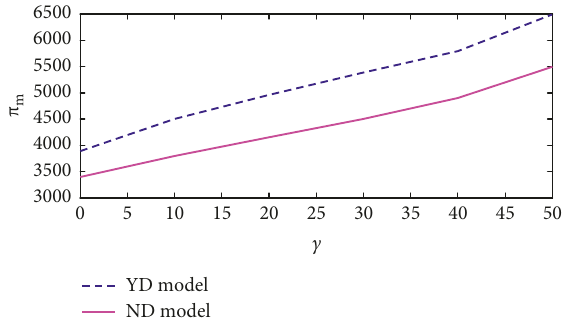
Figure 4: The impact of c on the manufacturer’s profit under the ND model and YD